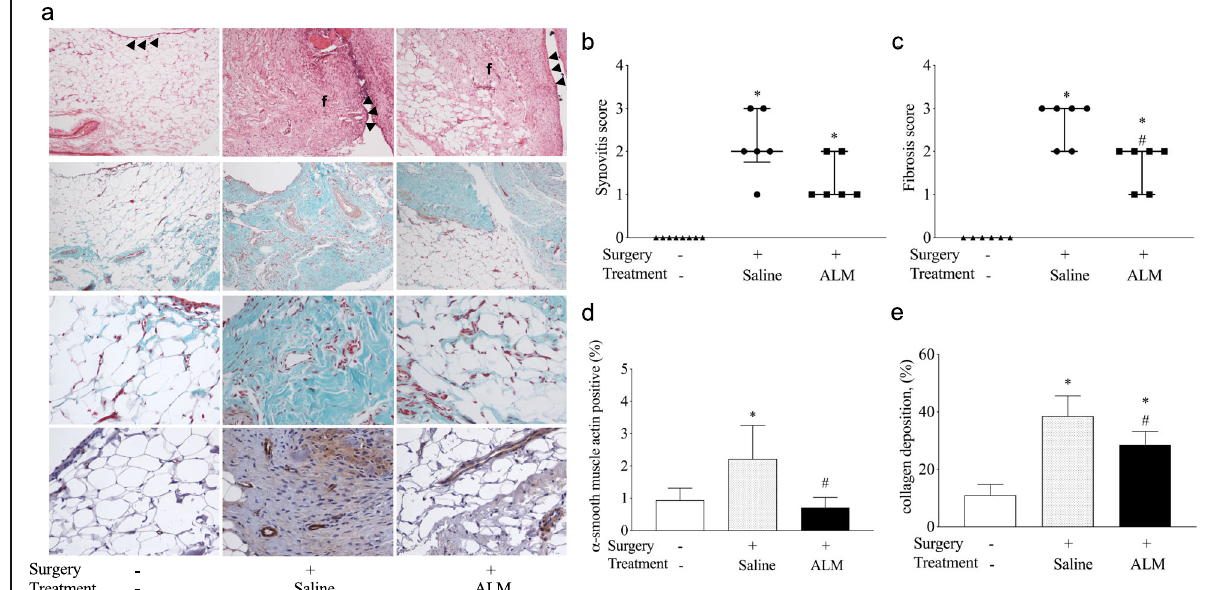
Fig. 2 ALM reduced fibrosis in the infrapatellar fat pad following knee implant surgery. At 4 weeks post-surgery, intact knee joints from non- operated, and operated knees of animals that received an intraoperative, intra-articular bolus of saline or ALM were decalcified and processed for histology. a Representative stained section of the infrapatellar fat pad (IFP) (upper panels: hematoxylin and eosin; magnification, × 100; middle panels: Masson Goldner trichrome magnification, × 100 and × 400; lower panels: α -SMA, magnification, × 400) from non-operated, operated saline-treated and ALM-treated knees. Histopathological features of IFP inflammation were scored according to changes in the synovial lining (arrowheads) and deposition of fibrotic tissue (f). Compared to saline controls, b synovitis, and c fibrosis was significantly reduced in IFP from ALM-treated animals. Similarly, the percentage of tissue positive for d α -SMA and e collagen staining was significantly reduced in ALM-treated knees, compared to saline controls. Data shows mean ± SD, * P < 0.05, vs. baseline (no surgery, no treatment), # P < 0.05, compared to saline controls; n = 6 per